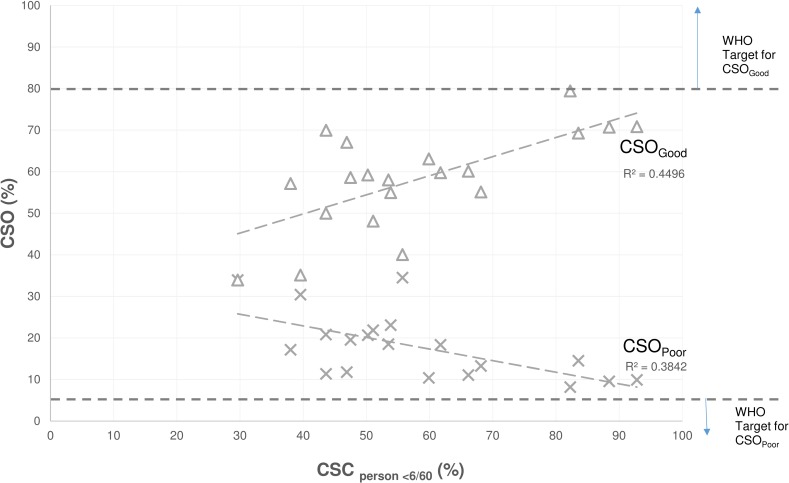
Proportion of operated eyes with presenting visual acuity of 6/18 or better (CSOGood) or worse than 6/60 (CSOPoor) plotted against observed cataract surgical coverage (CSCpersons <6/60, %) in 20 countries, 2005–2013.WHO Targets established in 1998.[31].